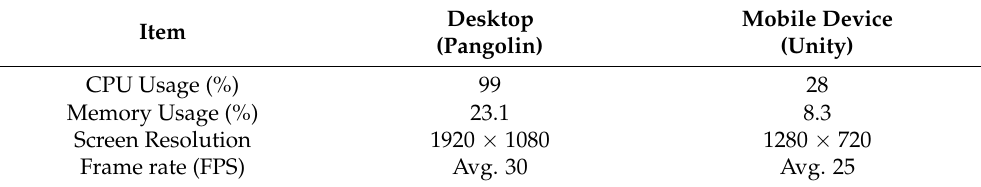
Desktop (Pangolin)